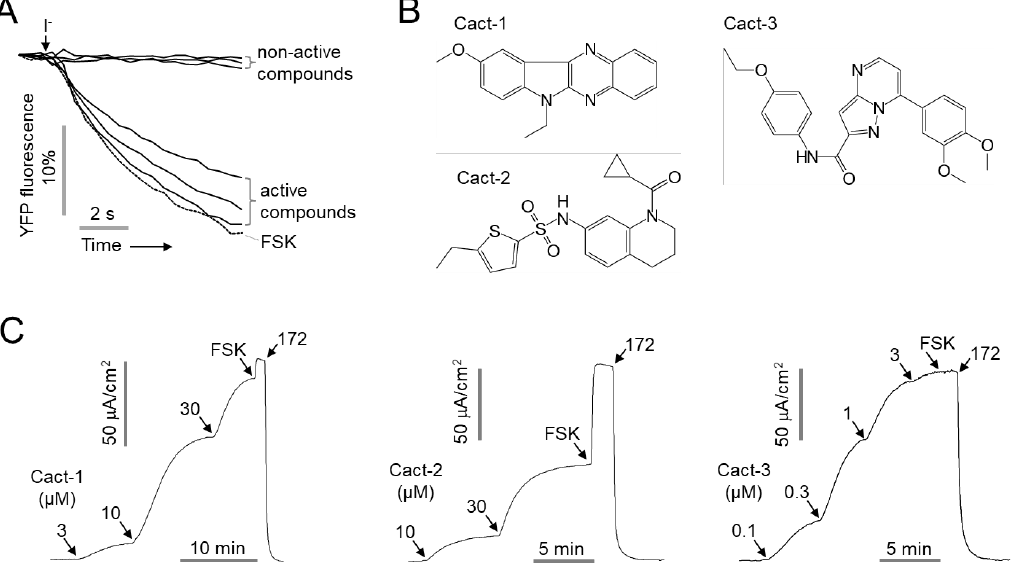
Figure 1. Identification of novel small molecule activators of CFTR. ( A ) Representative traces of YFP fluorescence measured in FRT cells expressing human CFTR. The cells were pretreated with 25 µ M of test compounds for 10 min. CFTR was activated by 20 µ M forskolin (FSK). ( B ) Chemical structure of novel CFTR activators. ( C ) Apical membrane currents were measured in FRT-CFTR cells in the presence of a transepithelial chloride gradient. CFTR was activated with the indicated concentrations of Cact-1, Cact-2, and Cact-3. CFTR was fully activated by 20 µ M forskolin and inhibited by 10 µ M CFTR inh -172